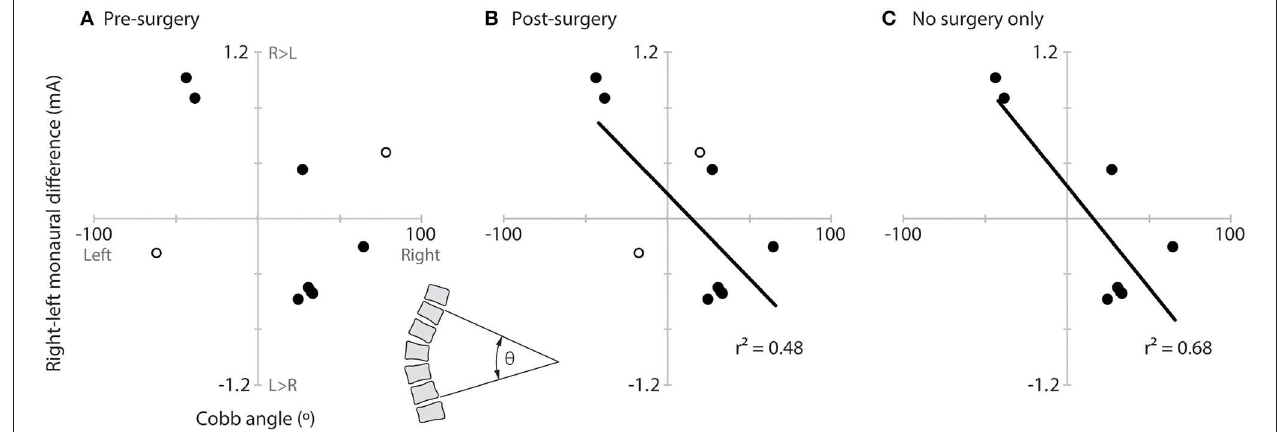
FIGURE 5 | Relationship of vestibular asymmetry to Cobb angle. Plots of the vestibular asymmetry (right–left recognition threshold) vs. Cobb angle (left curve negative, right curve positive) and significant linear correlations (lines and r 2 ) for (A) all AIS participants using the pre-surgery Cobb angle of the two post-surgery participants (hollow circles), (B) all AIS participants using the post-surgery Cobb angles of the two post-surgery participants (hollow circles), and (C) only the eight pre-surgery participants. The inset between panels (A,B) (bottom) illustrates how Cobb angle ( θ ) was